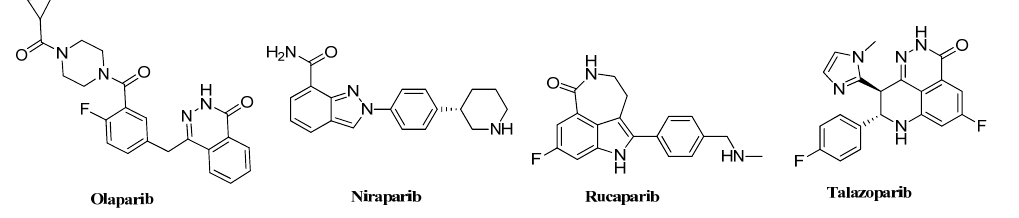
Figure 1. Structures of approved PARP inhibitors on the market.